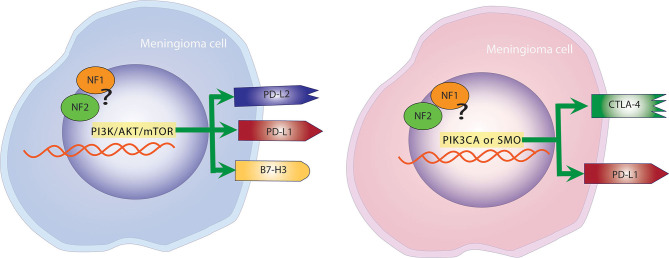
Mutational landscape determines the expression of checkpoint molecules. Left panel: Meningiomas with mutations in the PI3K, AKT, mTOR pathway are more likely to overexpress PD-L1, PD-L2, and B7-H3. Right panel: Meningiomas with alterations in PIK3CA and SMO are more likely to overexpress PD-L1 and CTLA-4.